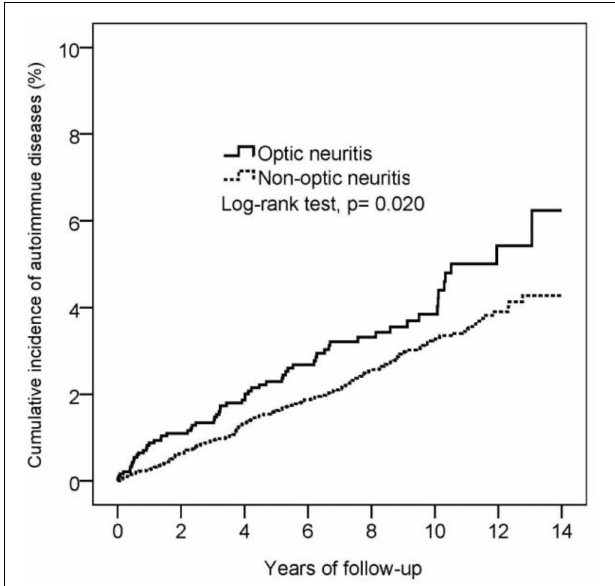
FIGURE 2 | Kaplan-Meier curve for the cumulative incidence of autoimmune diseases in the optic neuritis group and non-optic neuritis